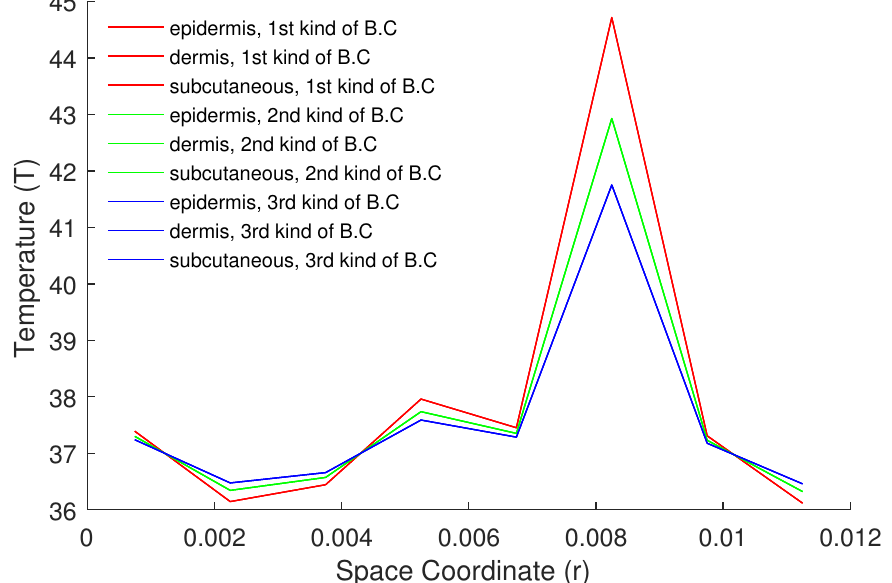
Figure 2. Temperature distributions for various kinds of boundary conditions.